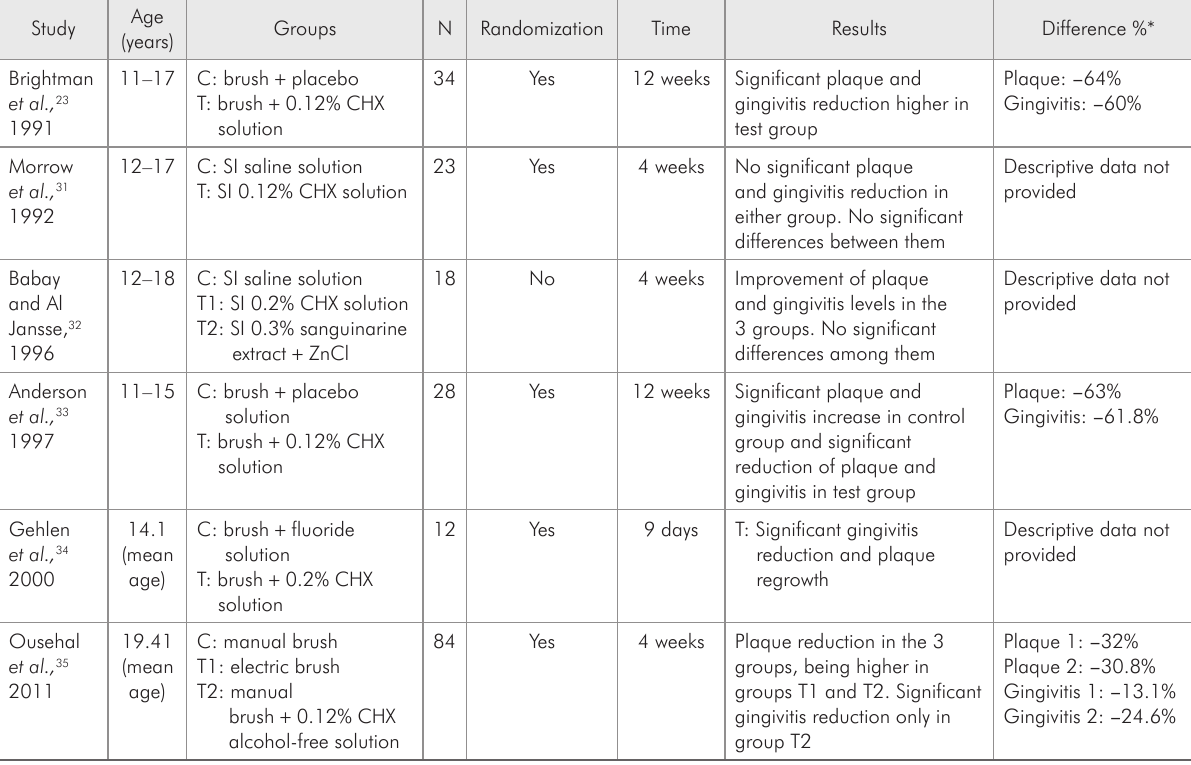
* Difference between test and control groups (negative sign indicates better result for the test group). C: control, T: test, SI: sub- gingival irrigation, CHX: chlorhexidine gluconate, ZnCl: Zinc